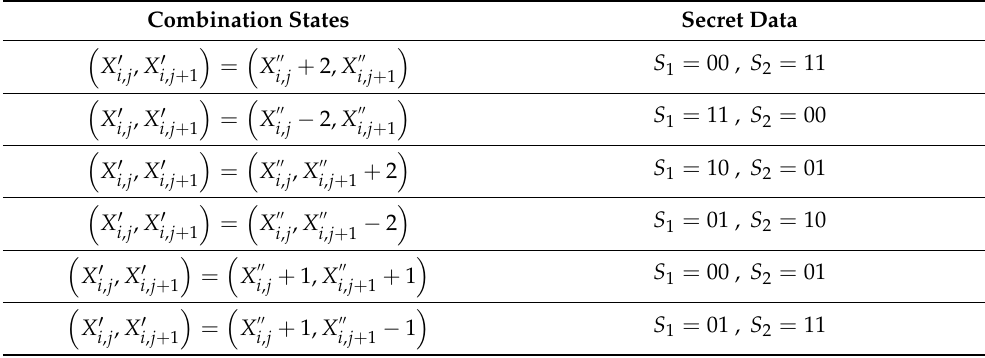
Table 1. Combination states and secret data values for data extraction process.